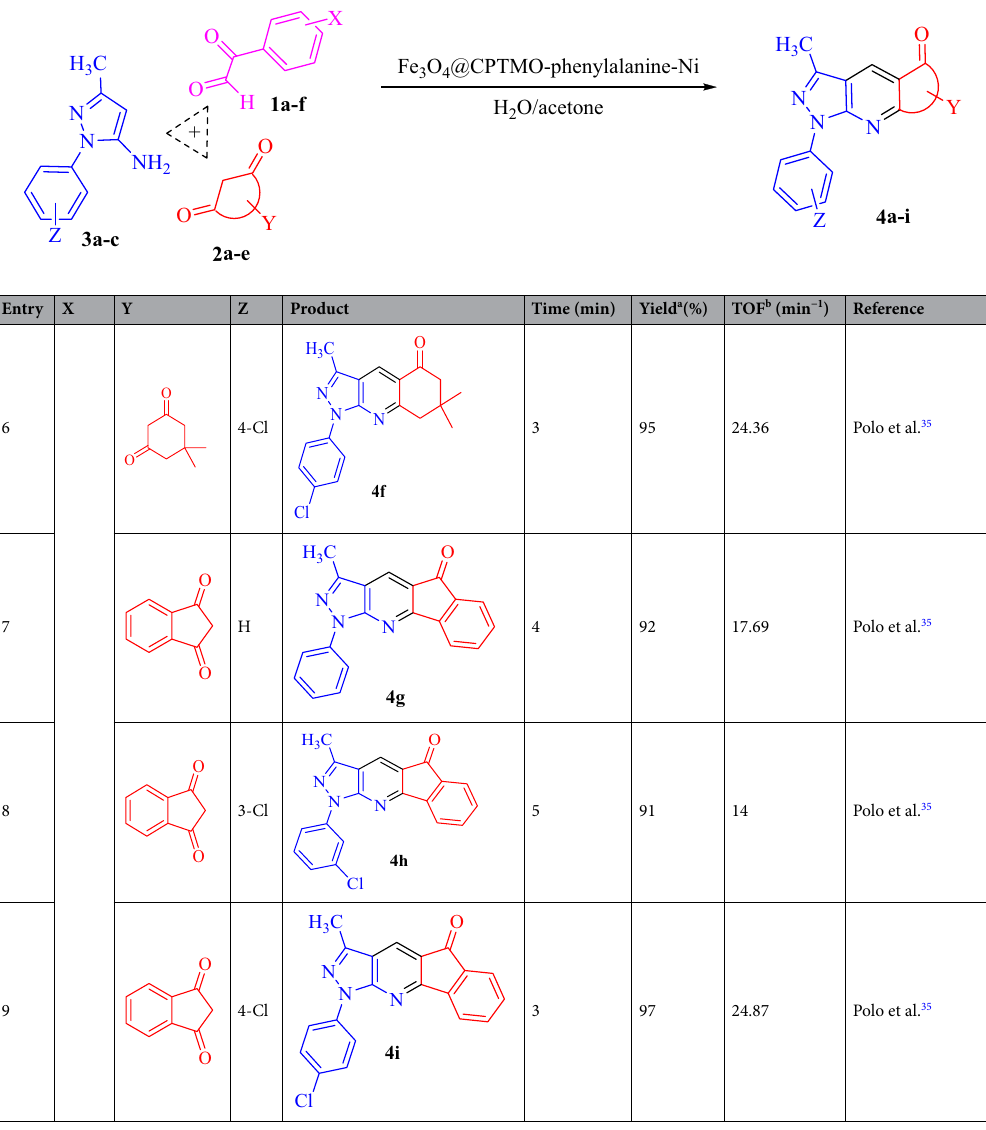
Table 3. Preparation of fused pyrazoles 4a-i catalyzed by Fe 3 O 4 @CPTMO-phenylalanine-Ni. Conditions: Arylglyoxals (1 mmol), cyclic 1,3-diketones (1 mmol), 3-methyl-1-aryl-1 H -pyrazol-5-amines (1 mmol), catalyst (30 mg) and H 2 O/acetone (10 mL), 3–7 min. a Isolated yield. b TOF = TON/time (min), TON = Yield (%)/(mol%, Cat, based on